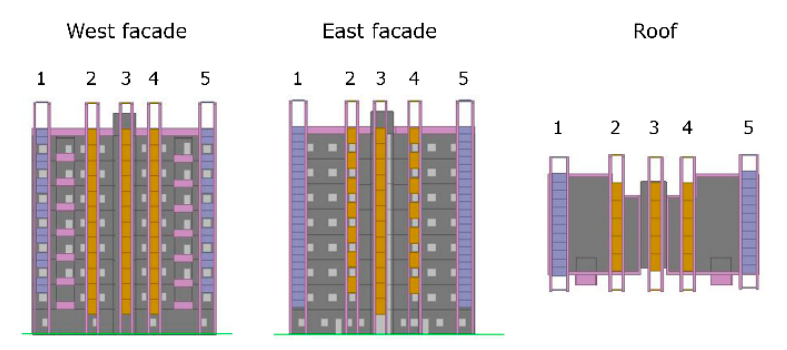
Figure 9. Arrangement of the five kits (PV modules in blue and thermal solar modules in orange).